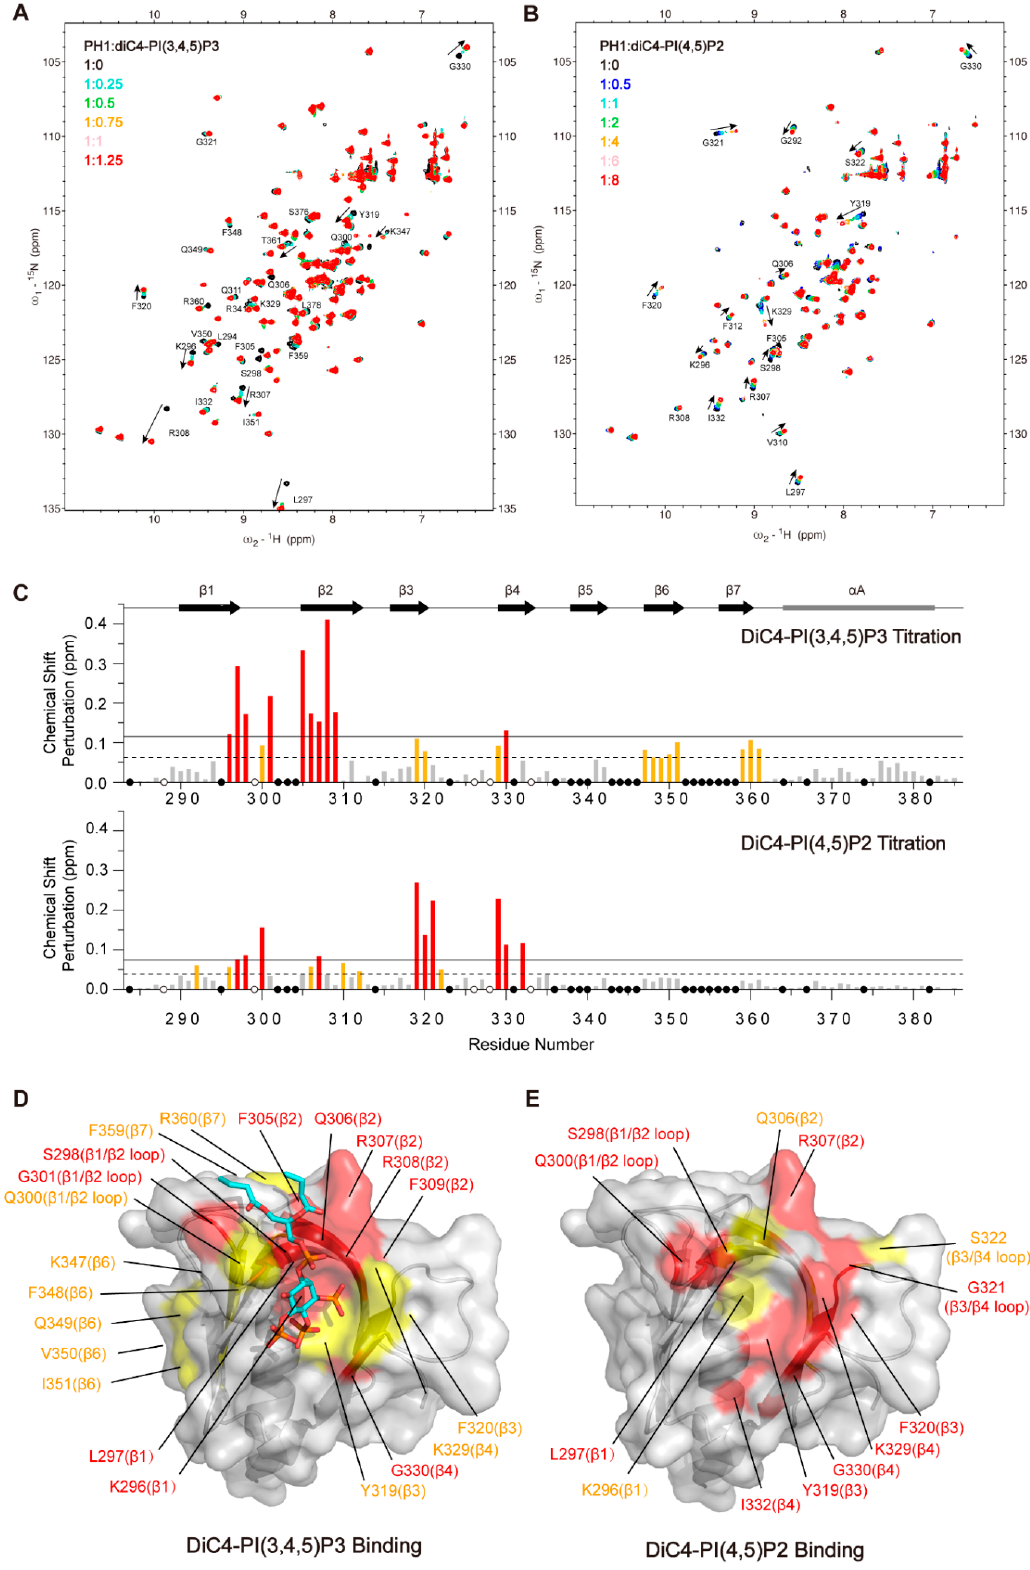
Figure 3. The binding interfaces of Arap3-PH1 for diC4-PI(3,4,5)P3 and diC4-PI(4,5)P2 revealed by NMR titration. ( A ) Overlay of 1 H- 15 N HSQC spectra of Arap3-PH1 in the absence (black) and in